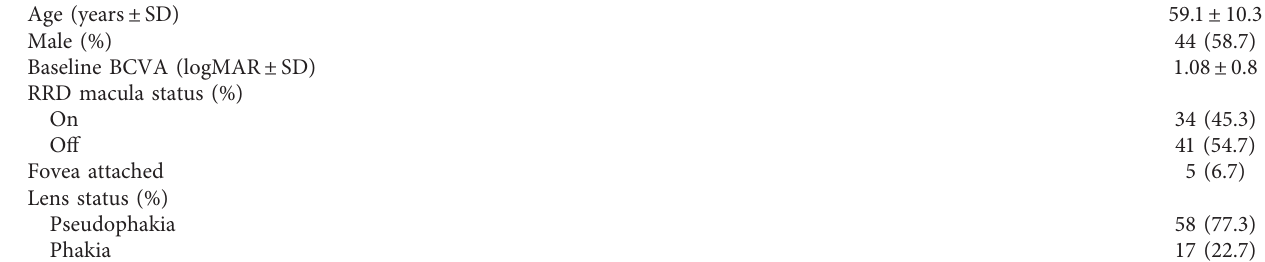
Table 1: Baseline characteristics expressed as mean ± SD and percentage (75 patients).